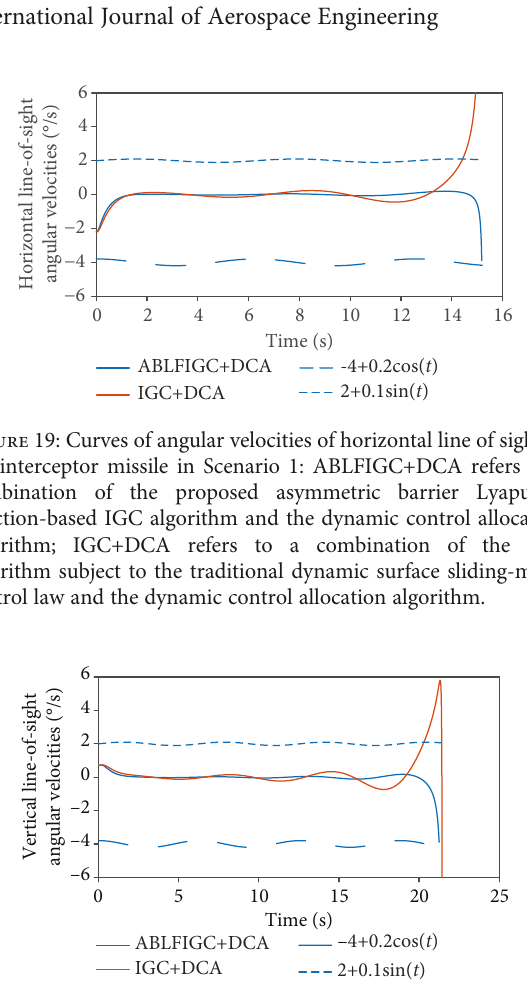
Figure 20: Curves of angular velocities of vertical line of sight of the interceptor missile in Scenario 2: ABLFIGC+DCA refers to a combination of the proposed asymmetric barrier Lyapunov function-based IGC algorithm and the dynamic control allocation algorithm; IGC+DCA refers to a combination of the IGC algorithm subject to the traditional dynamic surface sliding-mode control law and the dynamic control allocation